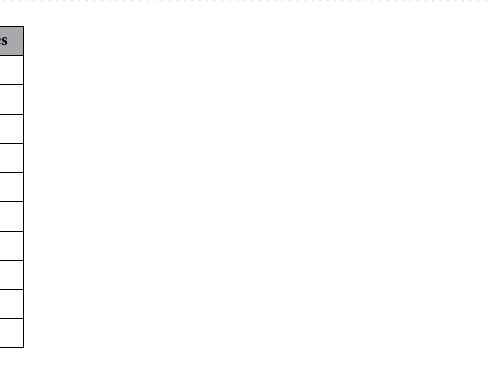
Table 4. Top 10 protein family domains encoded by faba bean unigenes revealed by a search of the Pfam